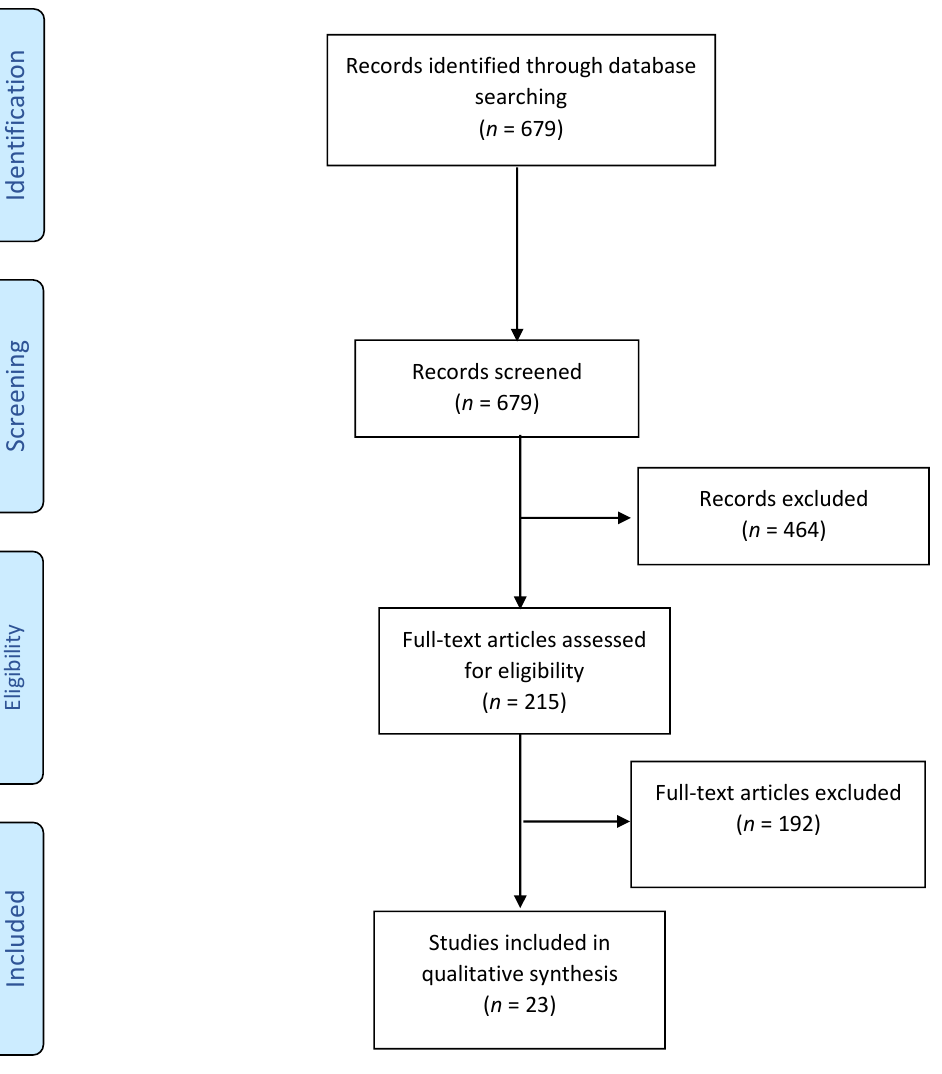
Figure 1.—Preferred Reporting Items for Systematic Reviews and Meta-analysis (PRISMA) flow chart.